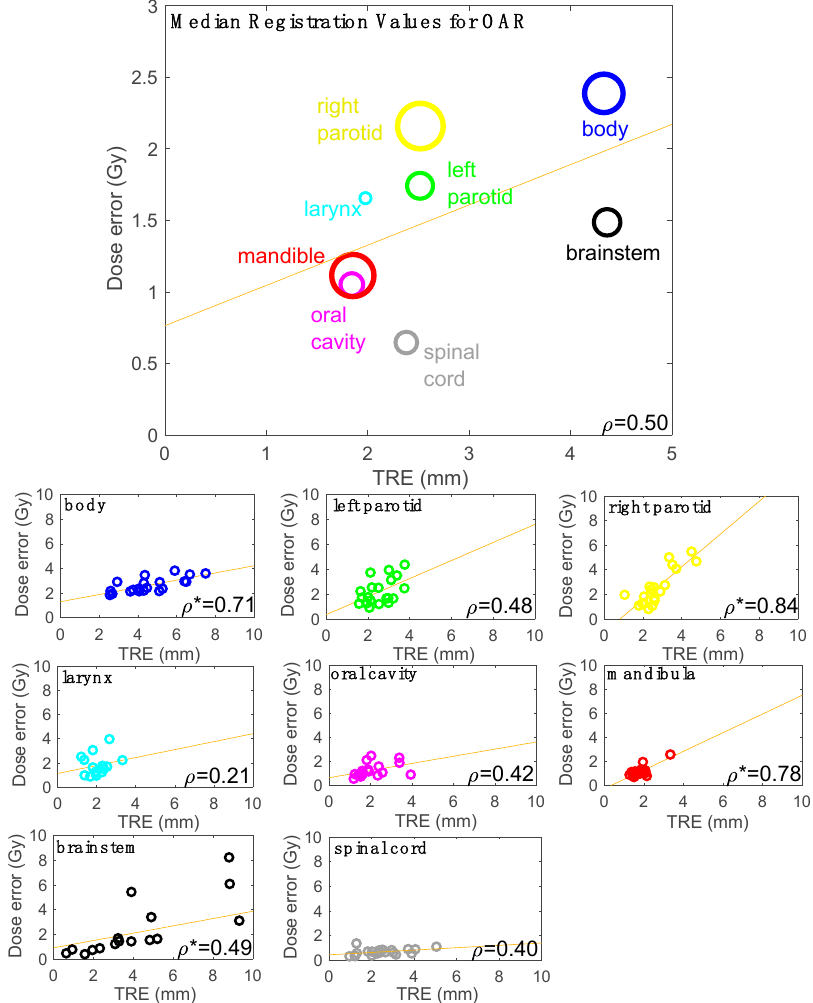
Figure 5. Upper panel: Correlation graph of the median TRE and dose errors values for each OAR. The diameter of each marker is proportional of the Pearson’s correlation coefficient value (see lower panels for individual numeric values). A linear correlation fit line is also reported. Lower panels: Correlation graph of the TRE and dose errors, across 20 registrations divided for each OAR. A linear correlation fit line is also reported. In the lower right corner of all panels, the Pearson’s coefficient was reported between TRE and dose error. A ‘*’ indicates that Pearson test confirmed statistically significant correlation.